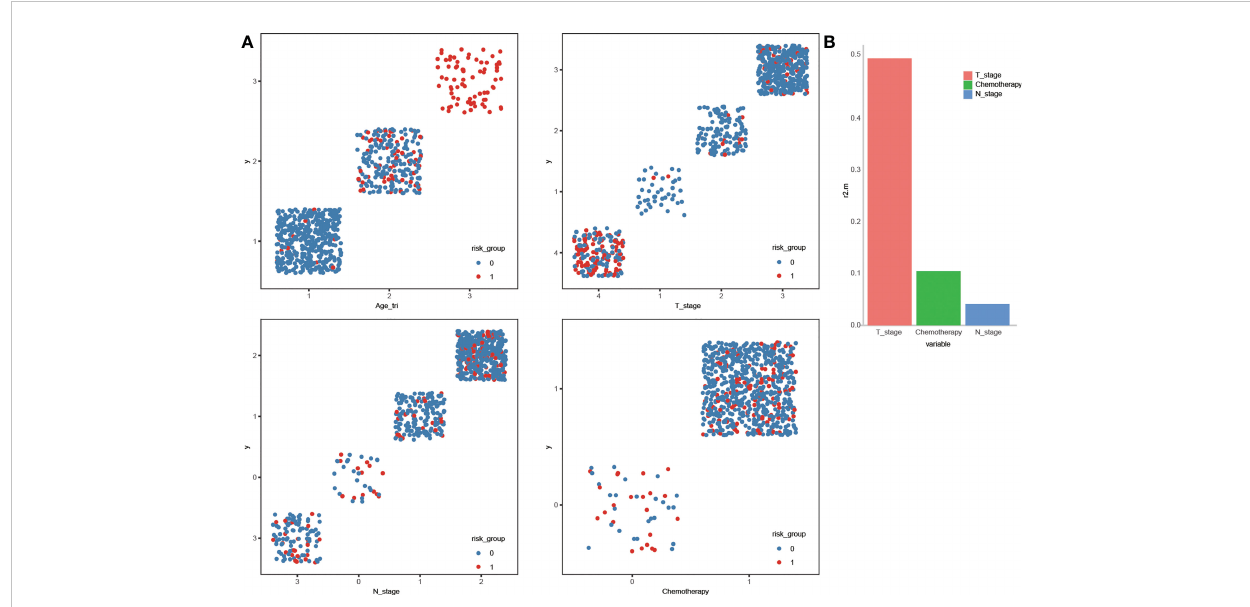
FIGURE 7 Scatter plot displaying the strati fi cation of high-risk and non- high-risk by the variables (A) . General dominance of independent predictors for becoming high-risk in locoregionally advanced nasopharyngeal carcinoma (B)